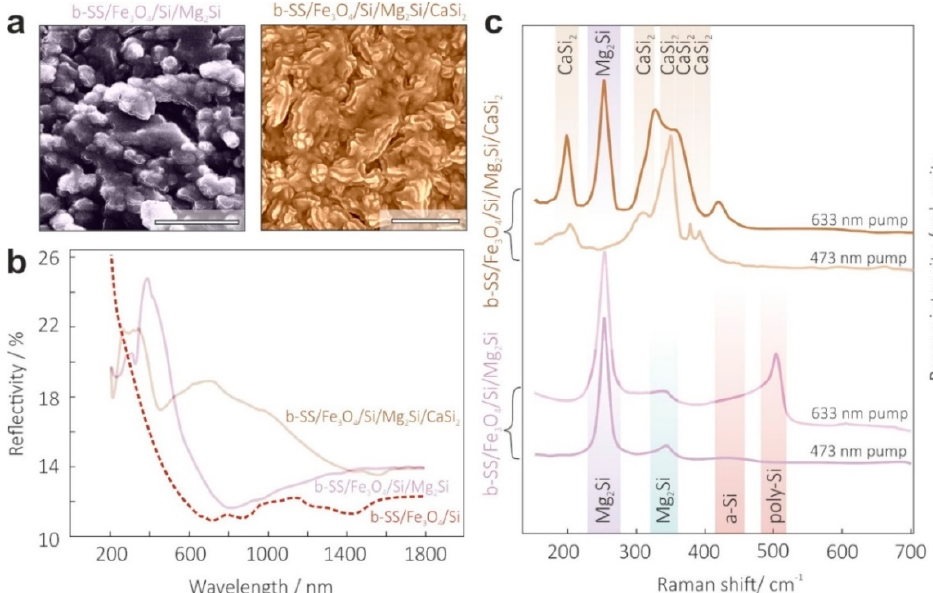
Figure 4. Characterization of the solar light absorbing Mg 2 Si and transparent conducting CaSi 2 layers. ( a ) Top-view SEM images demonstrating drastically changed surface morphology of b-SS/Si templates after consequent vacuum silicidation with magnesium ( left ) and calcium ( right ). ( b ) Optical reflectance spectra of intermediate b-SS/Fe 3 O 4 /Si and b-SS/Fe 3 O 4 /Si/Mg 2 Si samples, as well as resultant b-SS/Fe 3 O 4 /Si/Mg 2 Si/CaSi 2 SC. ( c ) Raman spectra of intermediate b-SS/Fe 3 O 4 /Si/Mg 2 Si ( bottom graphs ) and resultant SC structures ( upper graphs ) measured at 473 and 633 nm pump.